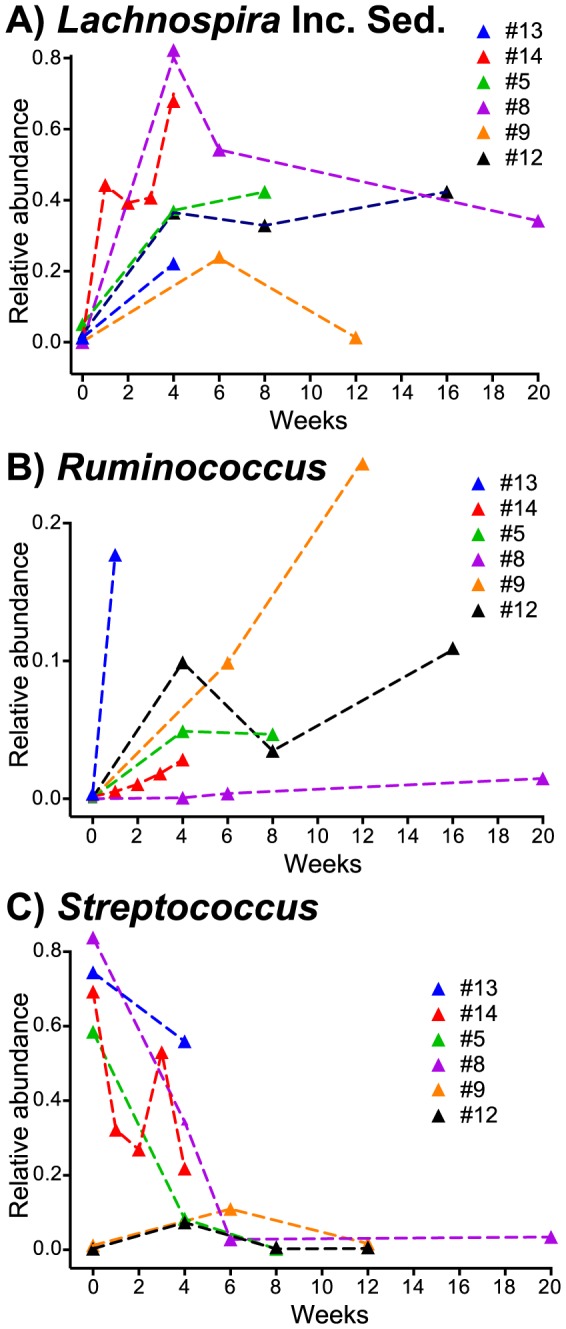
Post-FMT changes in selected microbiota members by case (genus level).(A) Lachnospira Incertae Sedis; (B) Ruminococcus; (C) Streptococcus. Genus-specific changes in relative abundance over time were not significant (p>0.05)when samples were grouped by time periods (1 week, 2–4 weeks, 6–8 weeks, 12–20 weeks) and groups compared with a non-parametric statistical test (Wilcoxon rank sum test).